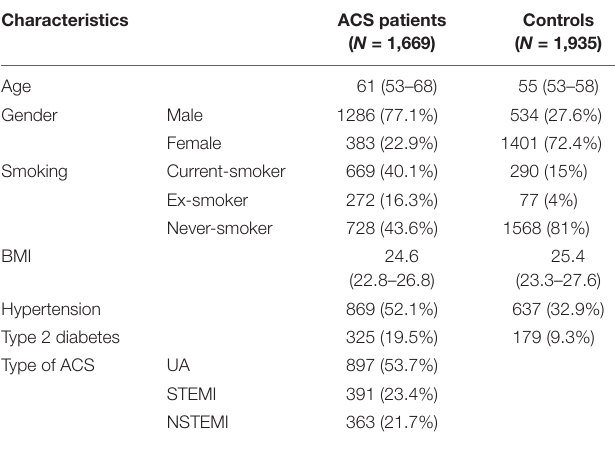
TABLE 1 | Summary of study subject